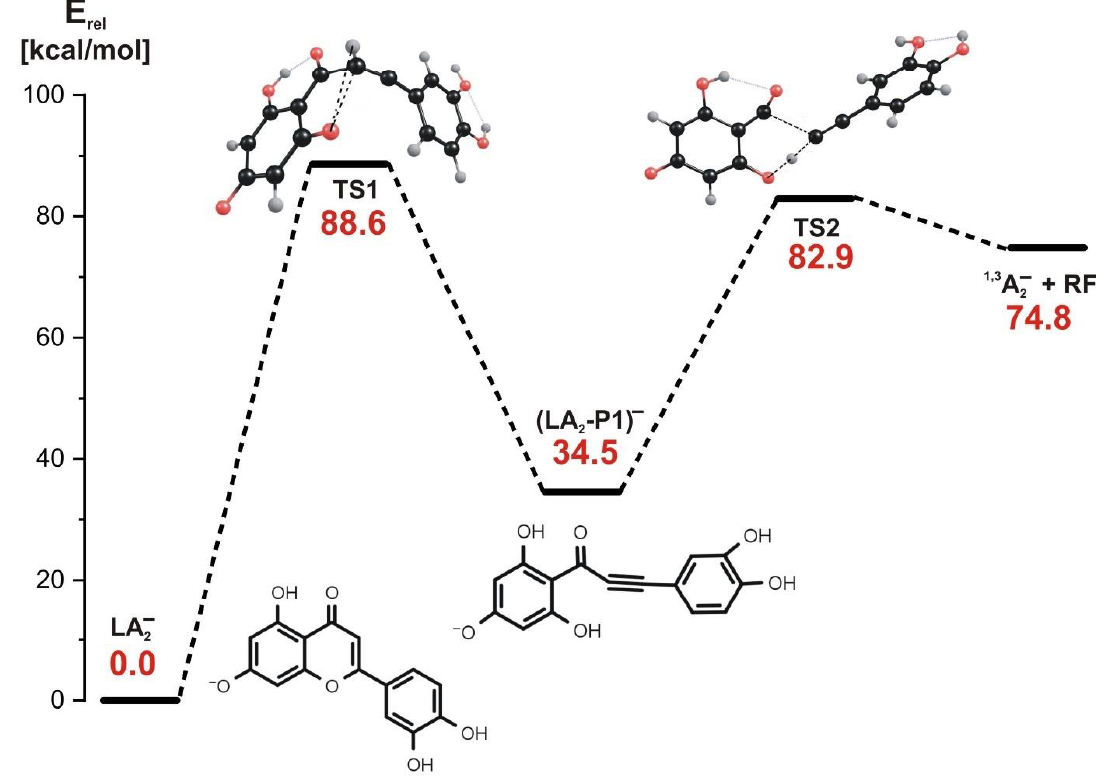
Figure 7. Energy profile for the 1,3-retrocyclization of LA 2- proceeding according to the stepwise mechanism and resulting in the formation of 1,3 A 2- negatively charged product. The energies of the transition states (TS1 and TS2), intermediate product ((LA 2 -P1) - ), and the separated products ( 1,3 A 2- anion and the remaining neutral fragment RF) are given (in kcal/mol) as the relative values (E rel ) with respect to the energy of the LA 2- substrate (taken as zero).